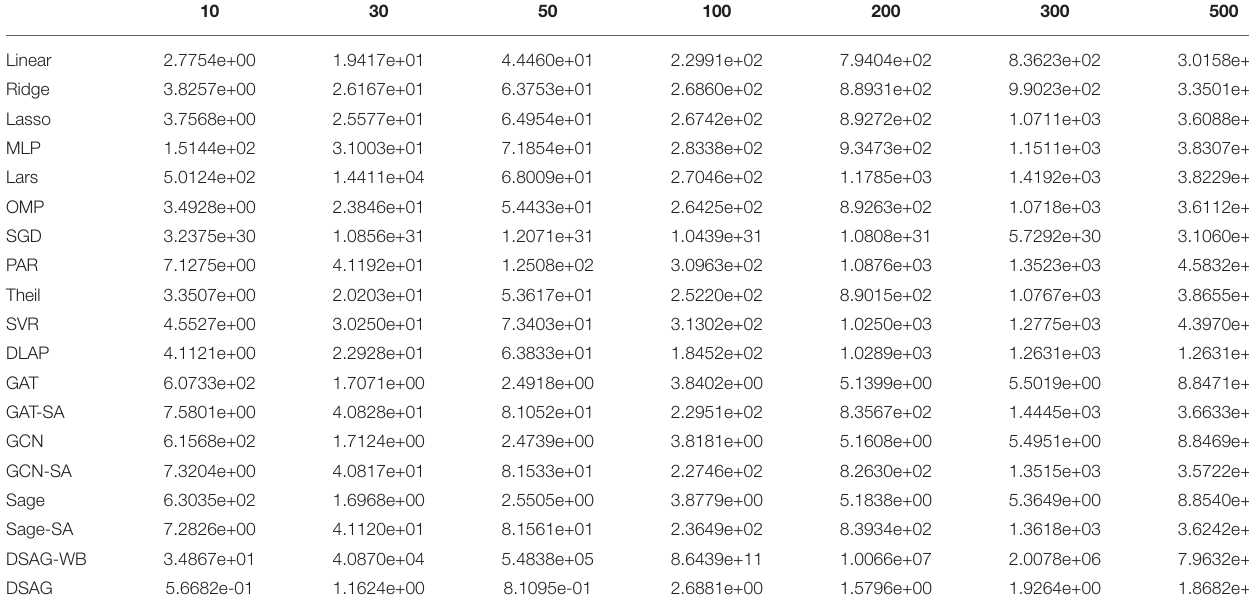
TABLE 3 | Performance comparison on